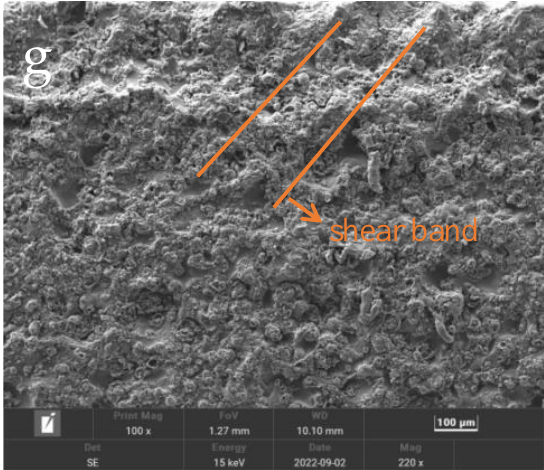
Figure 10. Microstructure of samples under different conditions: ( a ) 298.15 K, 6000 S − 1 , ( b ) 298.15 K, 7000 S − 1 , ( c ) 373.15 K, 6000 S − 1 , ( d ) 373.15 K, 7000 S − 1 , ( e ) 473.15 K, 6000 S − 1 , ( f ) 473.15 K, 7000 S − 1 , ( g ) 473.15 K, 7500 S − 1 .